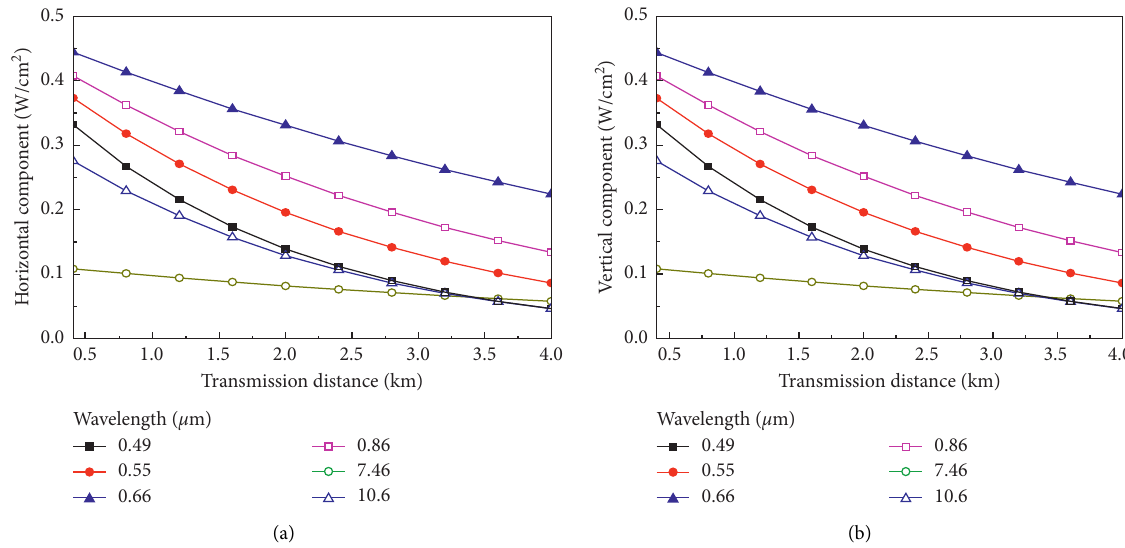
Figure 5: Circularly polarized laser [1, 0, 0, 1] (in a completely right-hand circularly polarized state) transmitted in. the Martian dust: (a) horizontal component of circularly polarized laser [1, 0, 0, 1] varying with the transmission distance and (b) vertical component of circularly polarized laser [1, 0, 0, 1] varying with the transmission distance.